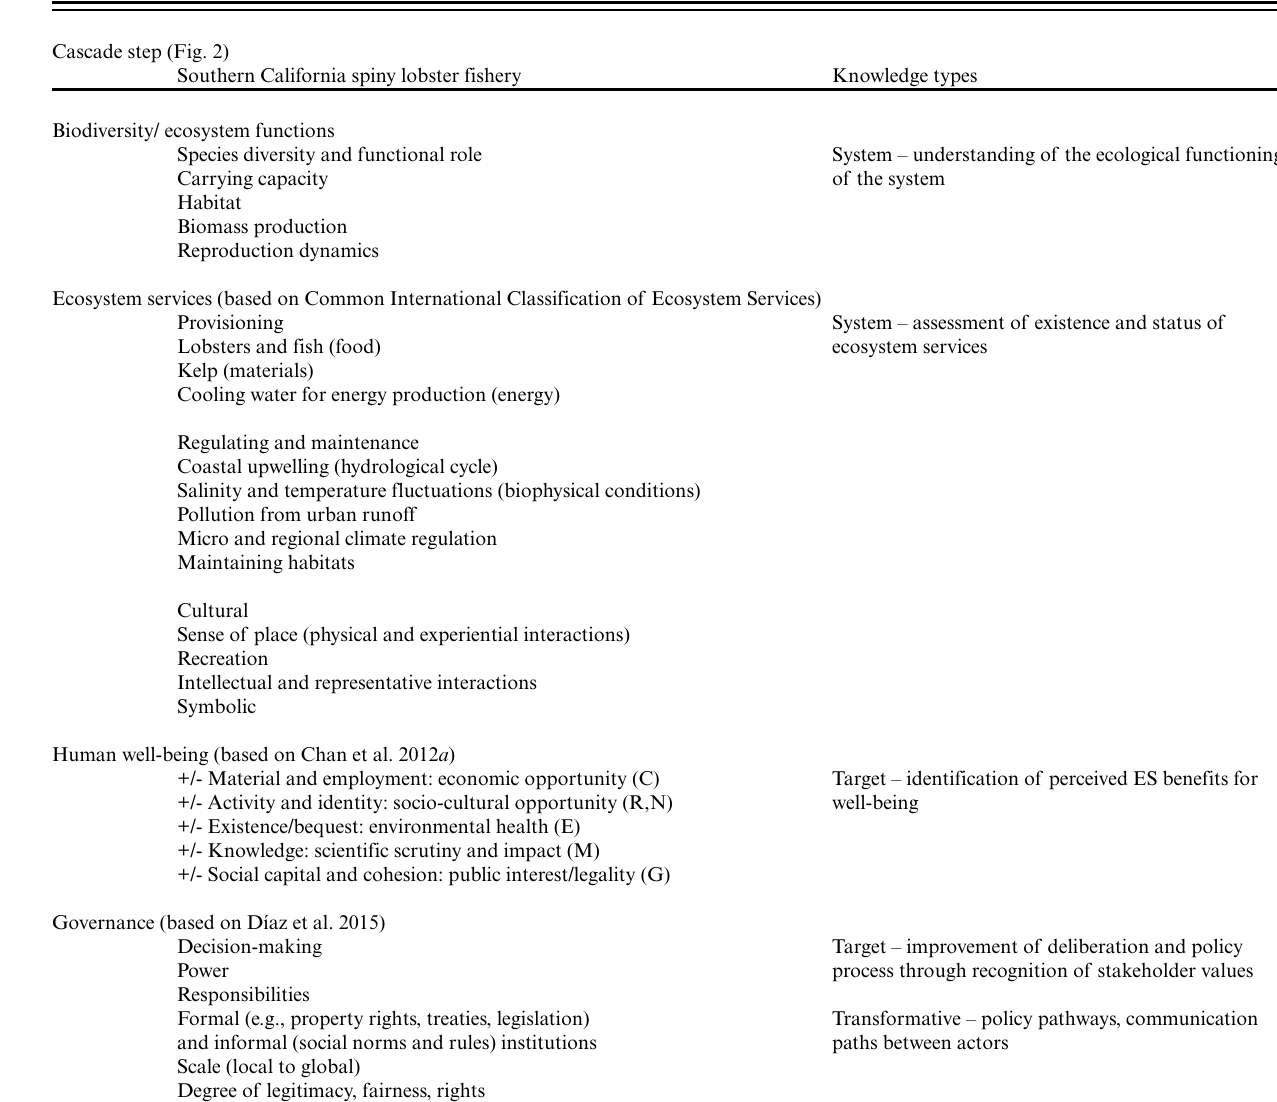
Table 2 . A demonstrative assessment of the Southern California spiny lobster fishery using the ecosystem services (ES) concept. Steps of the ES cascade are matched with case study data from the fishery and the knowledge types generated. Stakeholder groups: commercial (C), recreational (R), non-consumptive (N), environmental (E), marine science (M), and government